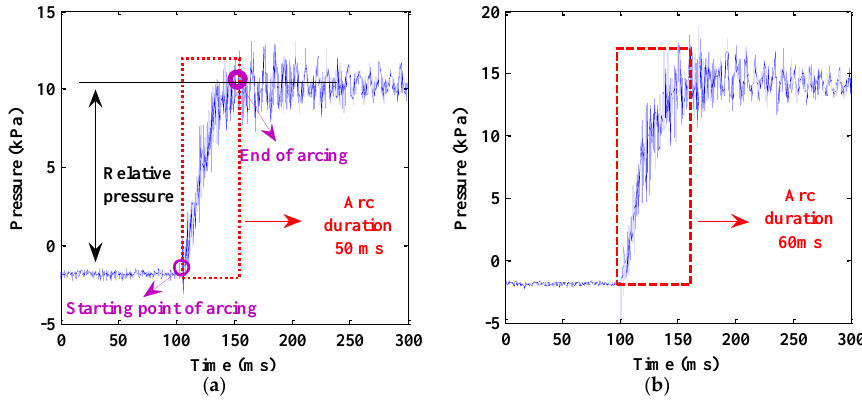
Figure 11. Change of the pressure rise with arc duration for different charging voltages. ( a ) 4.35kV; ( b ) 6 kV .